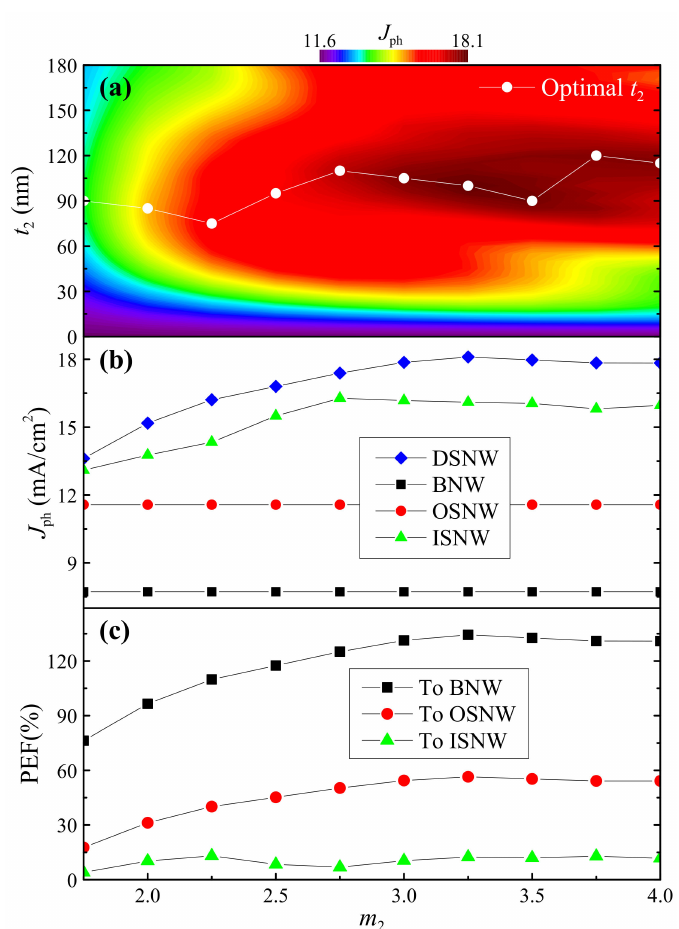
Figure 5. ( a ) J ph versus t 2 and m 2 of the DSNW. The white dashed line represents the position of the maximum J ph at various m 2 values. ( b ) J ph versus m 2 of the DSNW, corresponding to the optimal t 2 . Also, J ph versus m 2 of the BNW, OSNW and ISNW are included for comparison. ( c ) photocurrent enhancement factor (PEF) versus m 2 of the DSNW compared to the BNW, OSNW and ISNW, respectively. Note that the PEF is the photocurrent enhancement factor compared to the reference